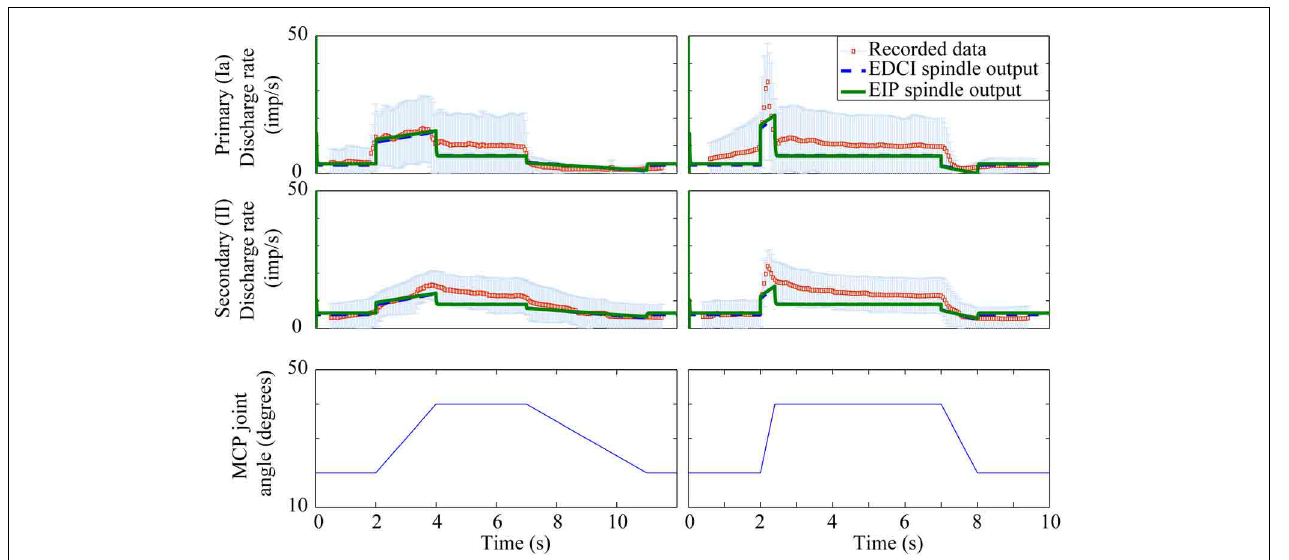
FIGURE 8 | Human muscle spindle firing patterns for imposed motions. Mean values and one standard deviation error bars are shown for recorded data from Edin and Vallbo (1990) and contrasted with modeled primary and